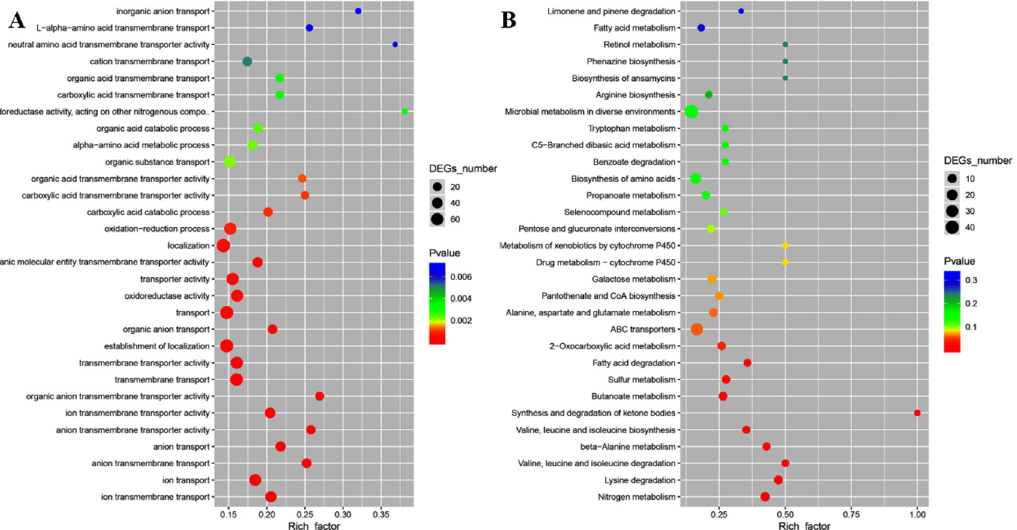
Figure 6. The GO enrichment scatter plot ( A ) and KEGG enrichment scatter plot ( B ) of differentially expressed genes treated with CFS from L. rhamnosus SCB0119 in E. coli ATCC25922. To illuminate the antimicrobial mechanisms of CFS against E. coli and S. aureus , we further analyzed the DEGs involved in the biosynthesis of amino acids, ABC transporters, and fatty acid degradation in E. coli ATCC25922, and ribosome, aminoacyl-tRNA biosyn- thesis, DNA replication, oxidative phosphorylation, and fatty acid degradation in S. aureus ATCC6538. In E. coli ATCC25922, CFS increased the expressions of ilvN , ilvI , leuA , leuB , and lysC involved in the biosynthesis of amino acids by 2.08–8.75-fold and decreased the expressions of ABC transporter nikE , nikD , nikC , nikB , nikA , and fepD by 52.89–81.45% and the expression of adhP involved in fatty acid degradation by 27.94% (Table 1). More- over, the expression of osmY encoding one periplasmic protein was down-regulated by 18.14% (Table S3). In S. aureus ATCC6538, CFS upregulated the expression of genes en- coding 30S small subunits, 50S large subunits, and aminoacyl-tRNA by 3.66–104.47 folds and the expressions of atpD , atpA , atpE , and atpB related to oxidative phosphorylation